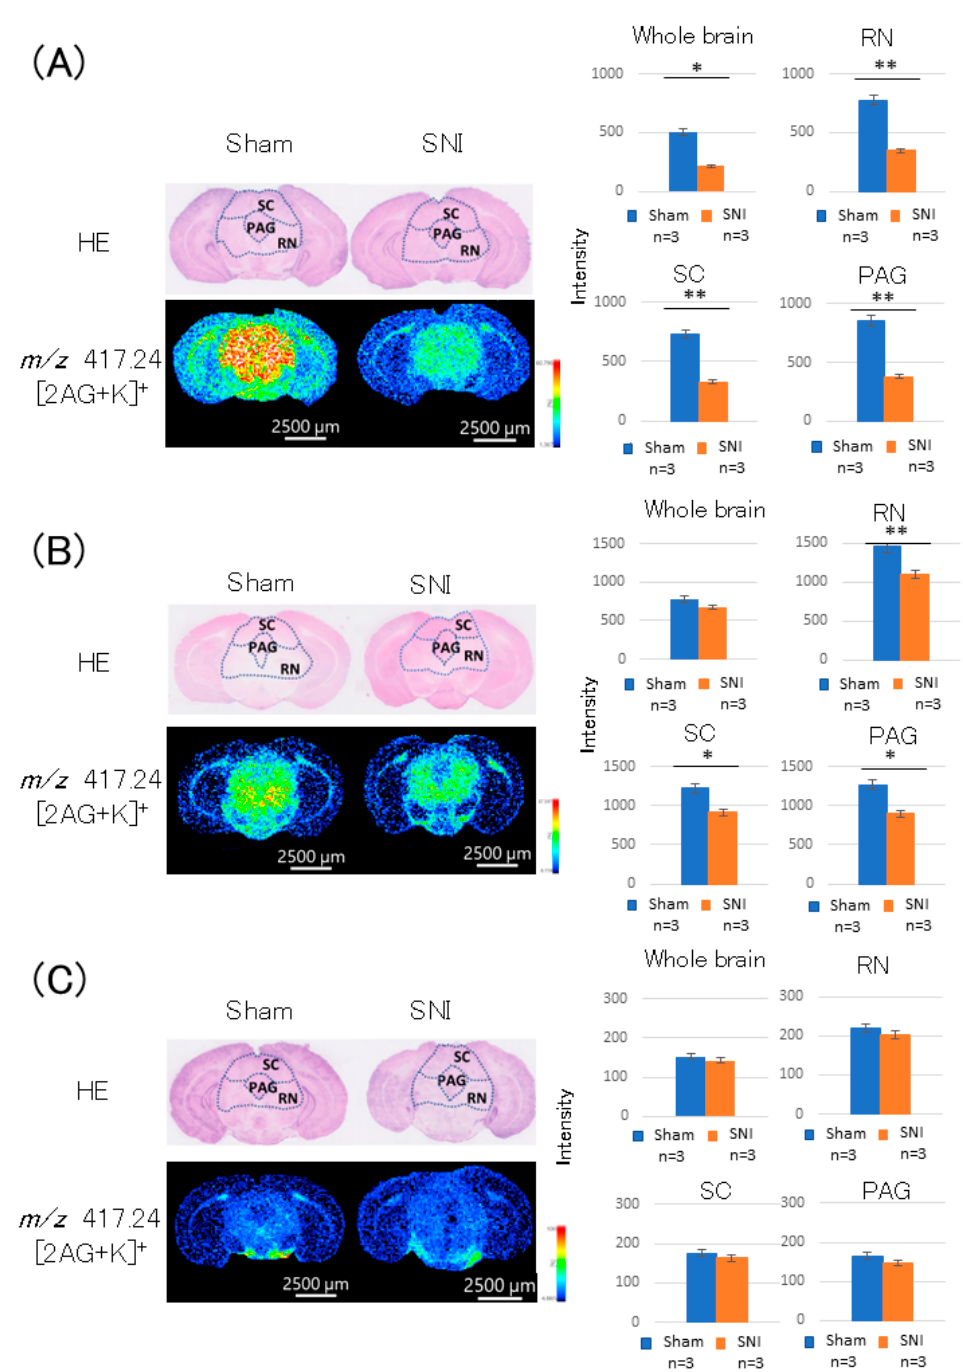
Figure 3. Detection of 2-AG in the PAG region of mice brains. ( A ) On day 3 post-treatment, 2-AG level in the whole brain was reduced in the SNI group. The difference was particularly pronounced in the midbrain; 2-AG levels in the superior colliculus (SC) and reticular formation (RN) were lower in the SNI group than in the sham group. 2-AG level in the PAG was also decreased in the SNI group. ( B ) On day 7 post-treatment, 2-AG level in the whole brain was reduced in the SNI group. In the midbrain, however, there was a difference in 2-AG between the two groups: 2-AG levels in the SC and RN were lower in the SNI group than in the sham group, similar to the result on day 3 post-treatment. 2-AG level in the PAG was also decreased in the SNI group. ( C ) On day 21 post-treatment, there was no difference in 2-AG level in the whole brain between the SNI and sham groups. There was also no difference in 2-AG levels in the midbrain and PAG between the two groups. *: p < 0.05,**: p < 0.01.